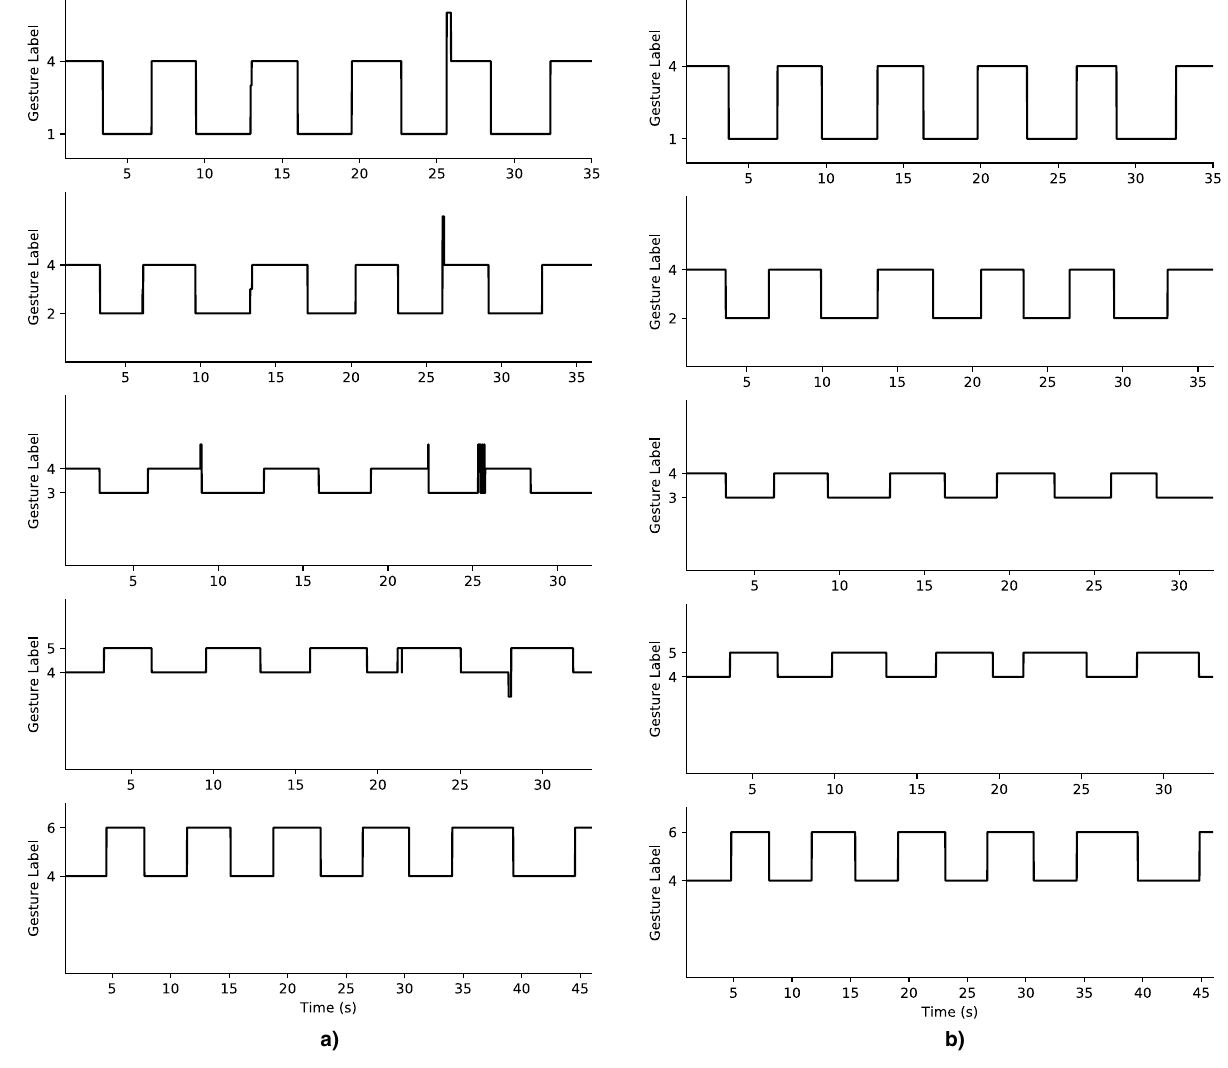
Figure 6. Real-time gesture trials of user 3. The user starts in a resting position (label ’4’) and completes 5 repetitions for each target gesture. ( a ) Trials with majority vote (200 inferences voting window). ( b ) Trials with thresholded majority vote (200 inferences voting window). A threshold of 102 votes has to be reached for the majority inference to update the output prediction. This results in 100% positive predictive value (PPV) for all